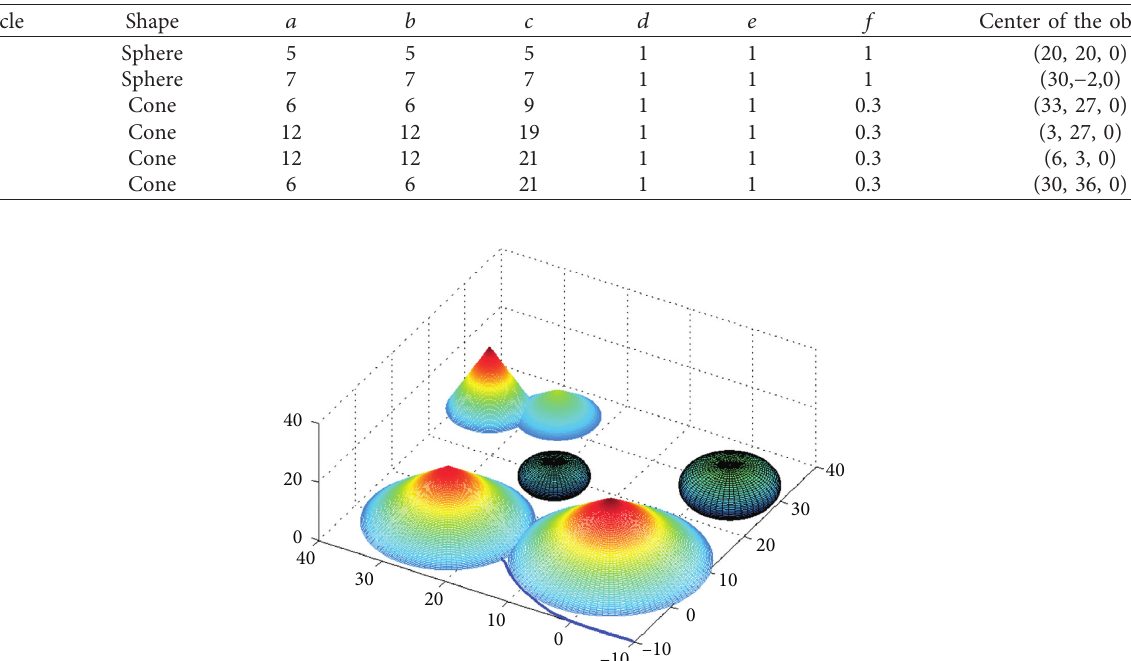
Figure 7: The robot falls into the trap area.